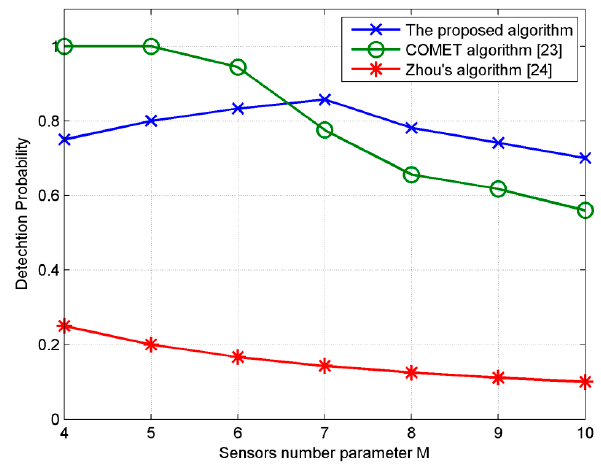
Figure 6. Detection probability by three algorithms with different numbers of sources and sensors.